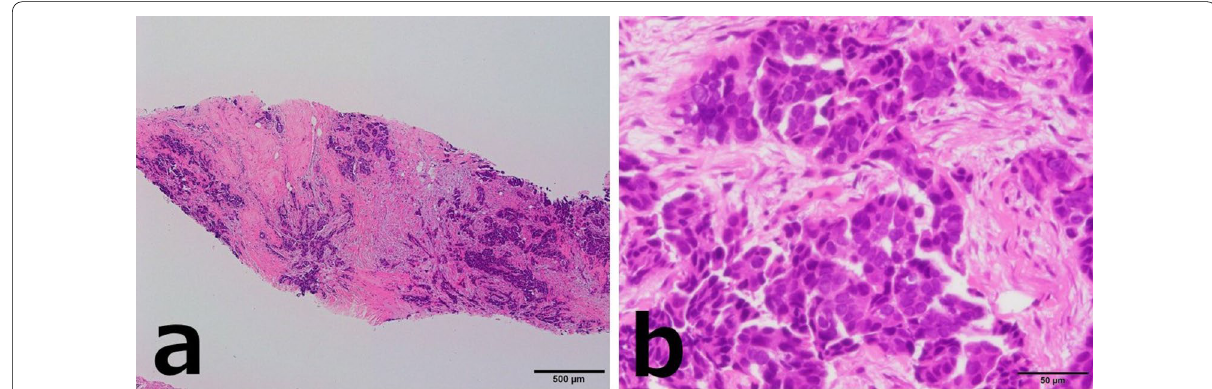
Fig. 2 Case 1: histopathological findings of the breast tumor (hematoxylin/eosin staining). a cytoplasm were arranged in irregular nests invading the